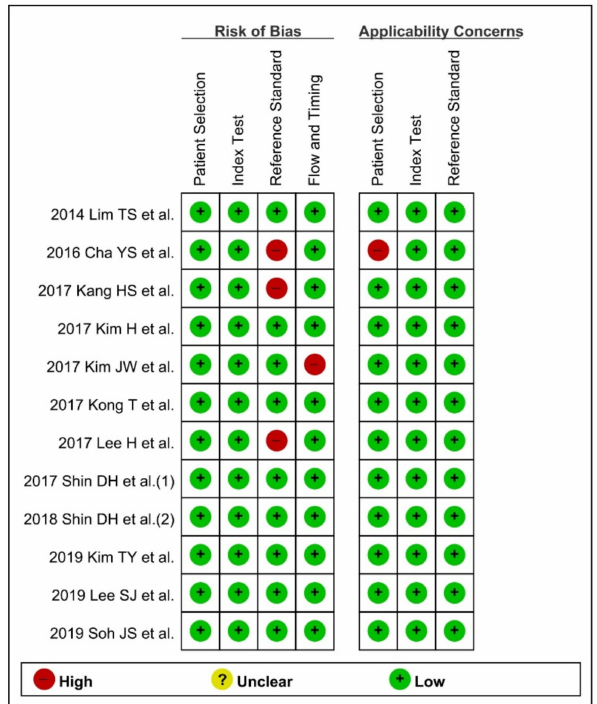
Figure 2. Quality Assessment of Diagnostic Accuracy Studies-2 for evaluation of methodology quality. ( + ) denotes low risk, ( − ) denotes high